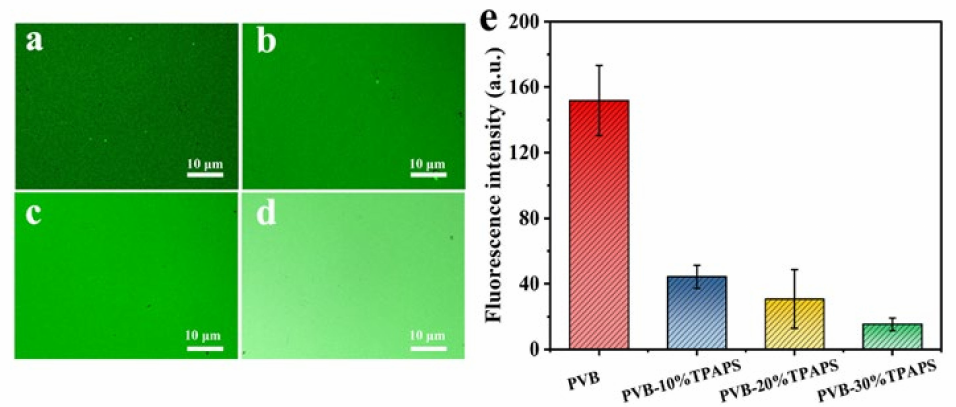
Figure 8. The representative fluorescent images of ( a ) PVB, ( b ) PVB-10%TPAPS, ( c ) PVB-20%TPAPS and ( d ) PVB-30%TPAPS after the adsorption of FITC-BSA. ( e ) The statistical fluorescence intensity for PVB-X%TPAPS coatings calculated from corresponding fluorescent images. Error bars represented the standard deviation of six independent